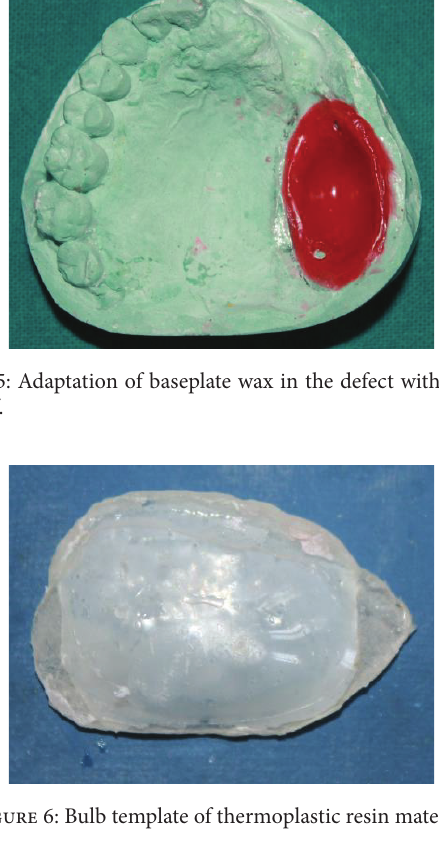
Figure 8: After dewaxing process.